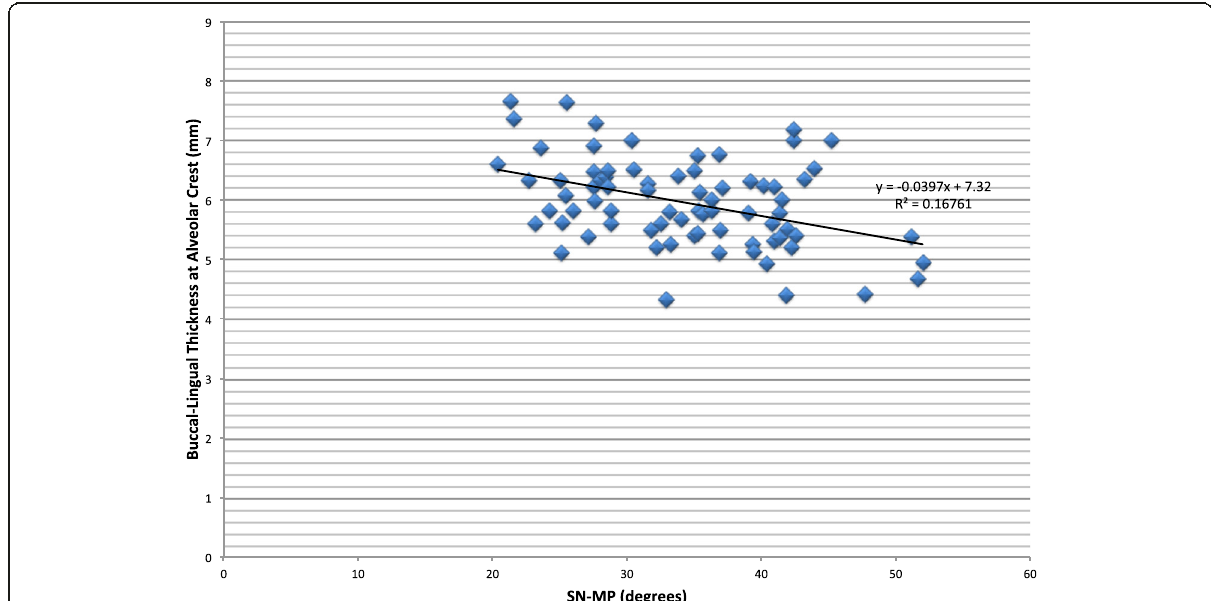
Fig. 5 Buccolingual thickness at the alveolar crest of the mandibular right central incisor versus mandibular plane angle. There is a negative correlation between the buccolingual bone thickness at the alveolar crest and SN-MP ( r = − 0.41, p value =